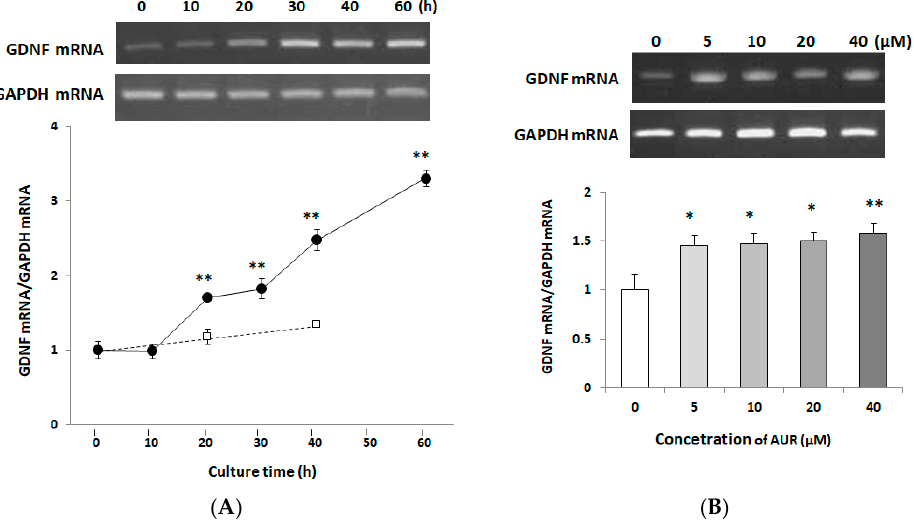
Figure 4. Effects of treatment with AUR on GDNF mRNA content in C6 cells. ( A ) Cells were incubated with 10 μ M AUR for various times (0–60 h) ( ● ) or without AUR for 20 or 40 h ( □ ). Significance difference in values between the non-treated and AUR-treated cells: ** p < 0.01; ( B ) Cells were incubated with various concentrations (0, 5, 10, 20, and 40 μ M) of AUR for 40 h. Significance difference in values between the none-treated (0 μ M) and AUR-treated cells: * p < 0.05; ** p < 0.01. In ( A ) and ( B ), the results are presented as the mean ± SEM ( n = 6).